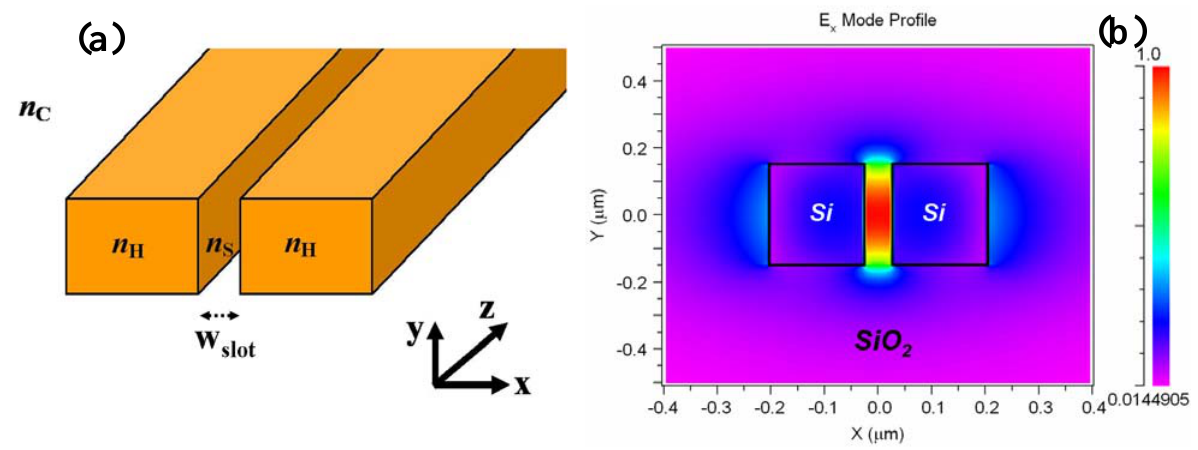
= 3.45)/SiO (n = n = 1.44) slot-waveguide at a wavelength H 2 S C